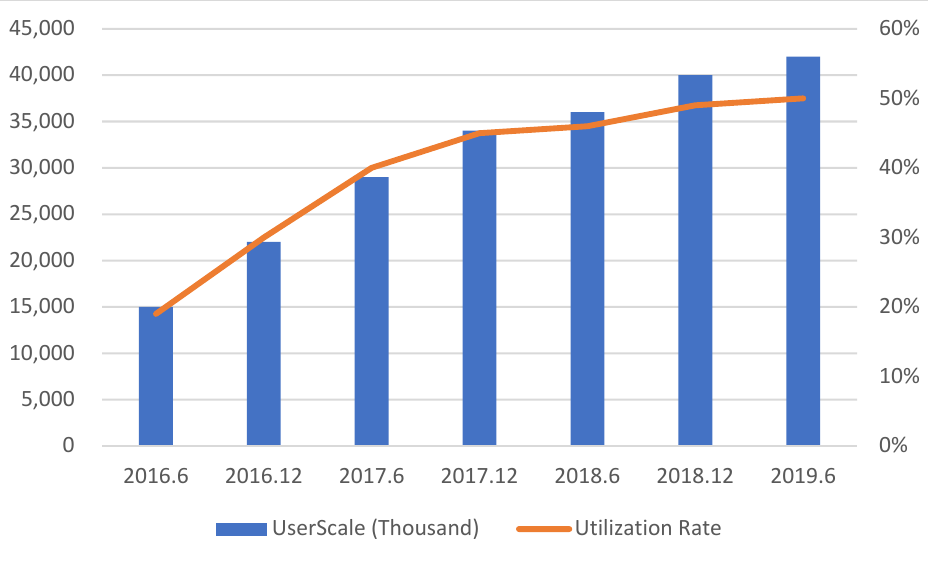
Figure 3. Scale and utilization rate of online takeout users from 2016 to 2019.